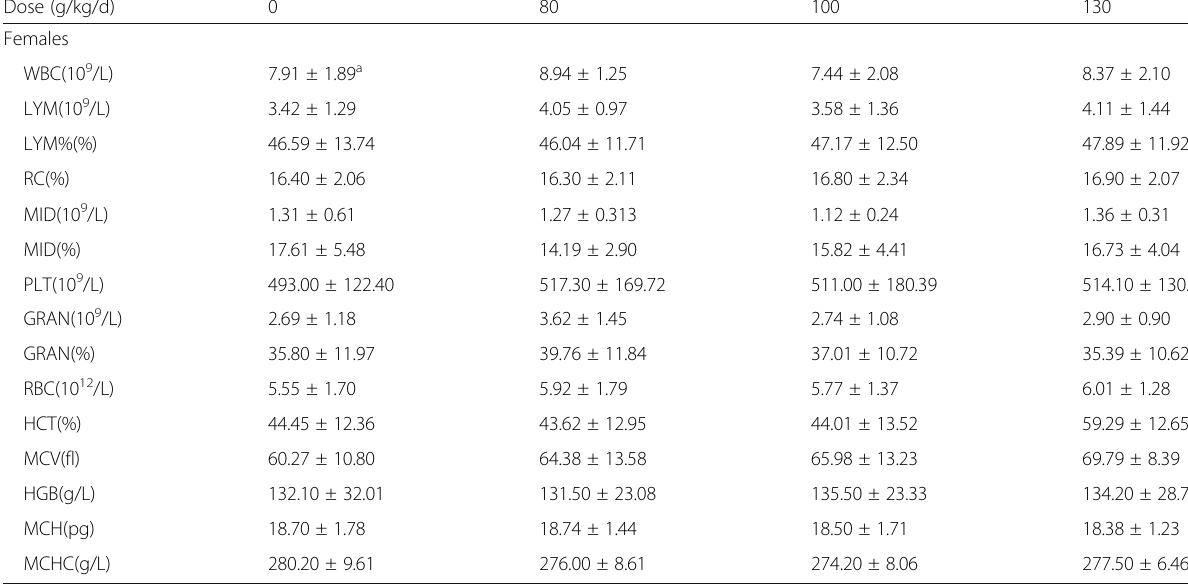
Table 7 Hematological data for female rats treated with JDHY granules for 13 weeks of treatment Dose